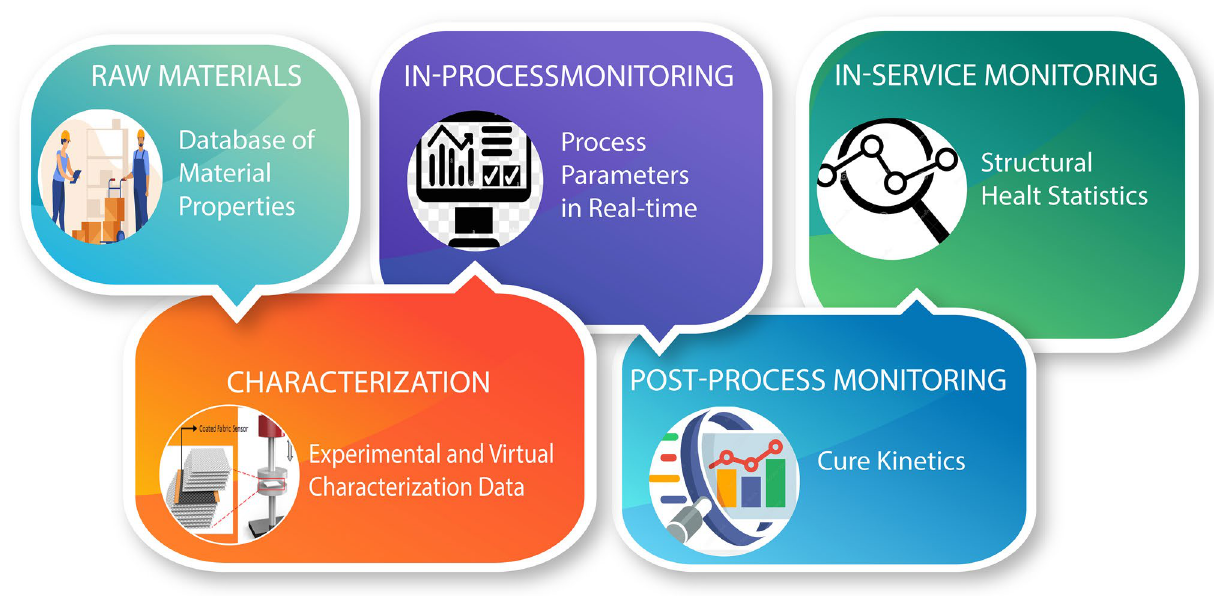
Figure 4. Data collection at various stages of composites manufacturing using block-chain technology. The data generated at various manufacturing stages including the data sheets of the raw materials and in-service signals can be gathered in an efficient and secure manner by using block-chain